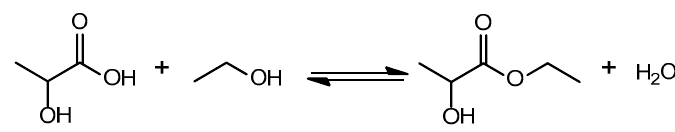
Figure 4. Idealized reaction scheme for direct esterification of lactic acid with ethanol (formation of oligomeric esters is neglected).